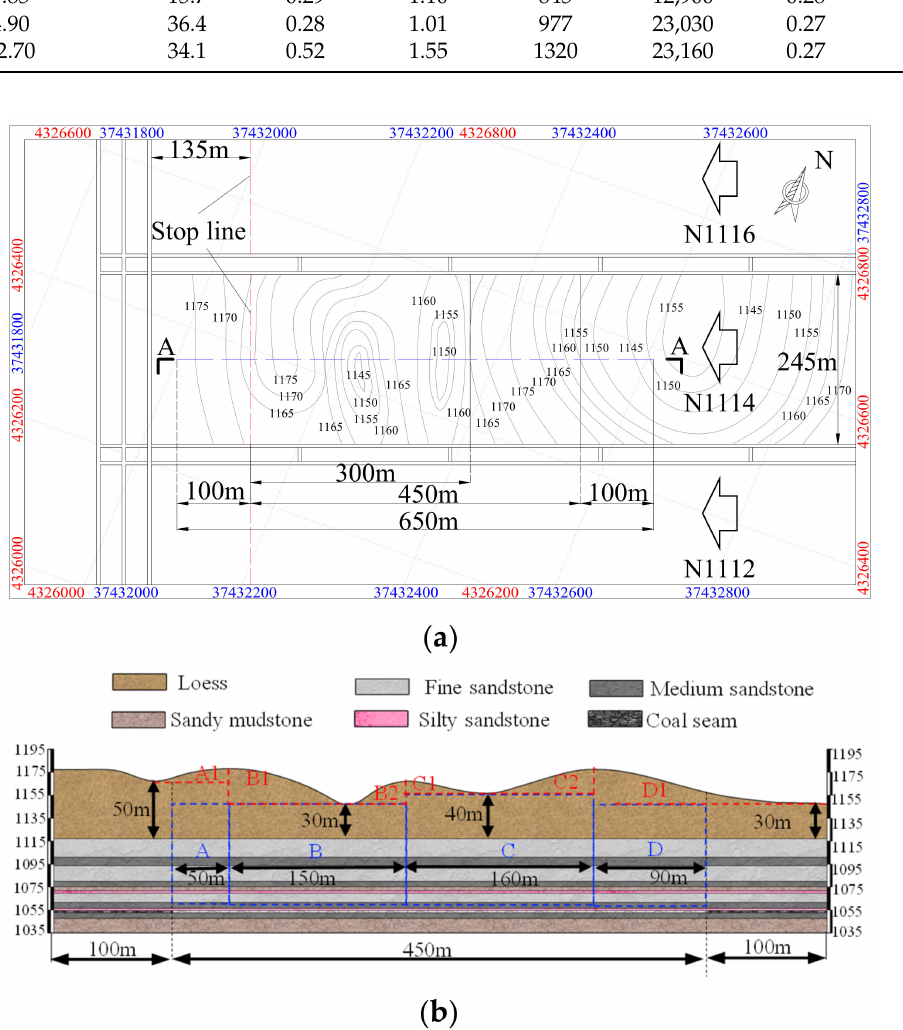
Figure 8. Overview of the N1114 working face: ( a ) work surface layout; and ( b ) A–A stratigraphic